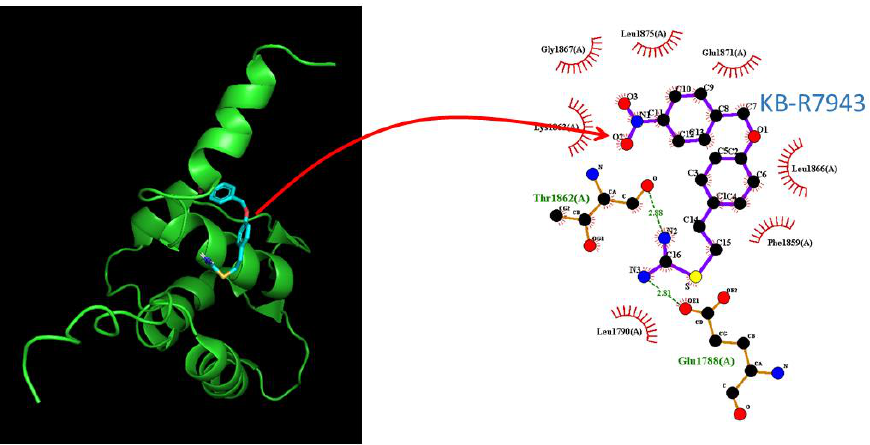
Figure 9. Molecular docking of the hNa V 1.2 channel and the KB-R7943 molecule. The chemical struc- ture of KB-R7943 was taken from PubChem (compound CID: 9823846), whereas the protein struc- ture of hNa V 1.2 was from RCB PDB (ID: 2KAV). We docked the KB-R7943 molecule to hNa V 1.2 with PyRx, and diagram of the interaction between the hNa V 1.2 channel and the KB-R7943 molecule was then generated from LigPlot + . Similar to those on the right side of Figure 8, the red arcs on which red small bars are faced and radiated toward the KB-R7943 molecule represent the hydrophobic interactions, whereas green dotted lines in amino acid residue (i.e., Glu1788(A) and Thr1862(A)) indicate the formation of hydrogen bonds.